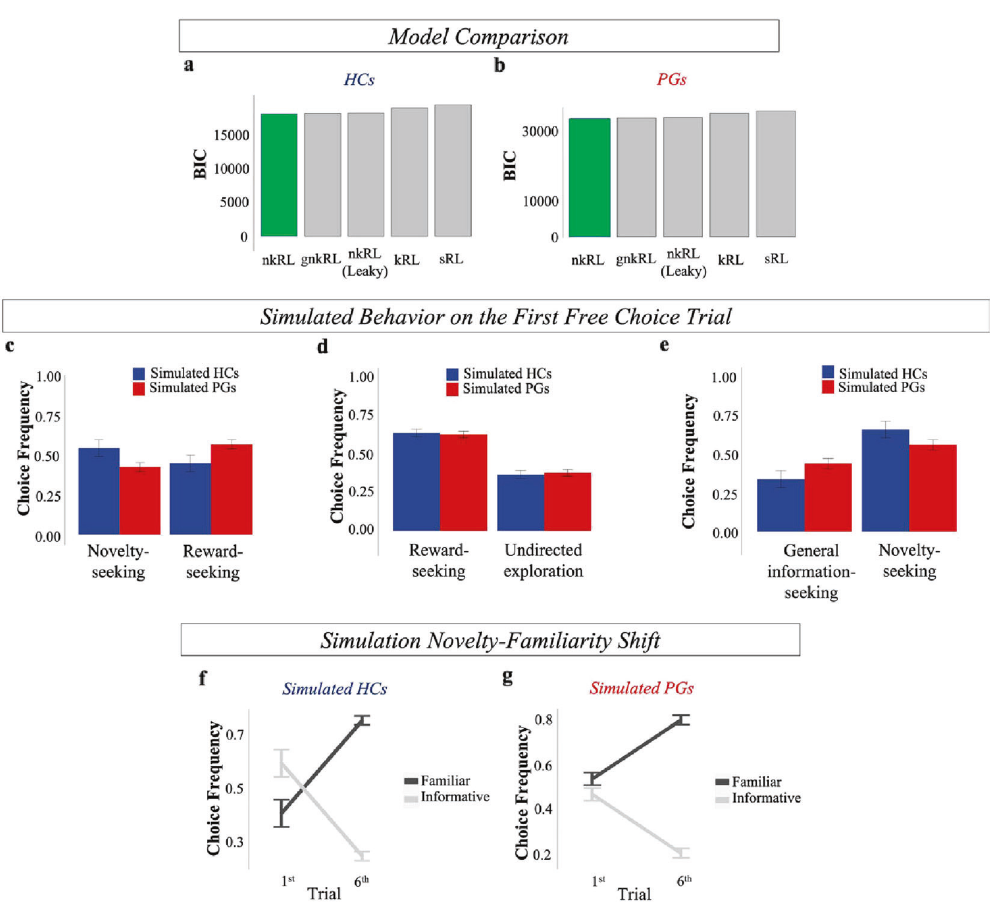
Fig. 3 Model Comparison and nkRL simulations. BIC comparison of the 5 RL models in HCs ( a ) and PGs ( b ). The comparative fi t is based on the sum of individual BIC computed by fi tting each model to participants ’ free choices. In both groups, the novelty-knowledge RL model (nkRL, in green) better explains participants ’ behavior compared to a leaky novelty-knowledge RL model (leaky nkRL), a knowledge RL model (kRL), a standard RL model (sRL), and a gamma novelty-knowledge RL model (gnkRL). By using the estimated individual